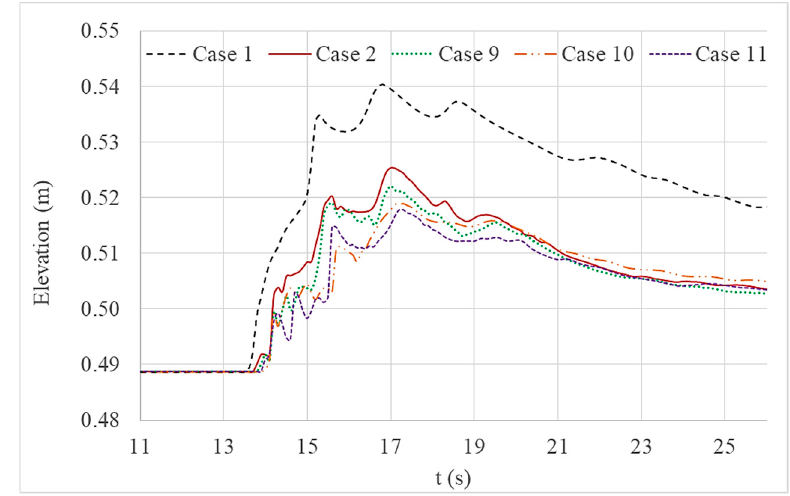
Figure 13. Comparison of water level variations at location D.